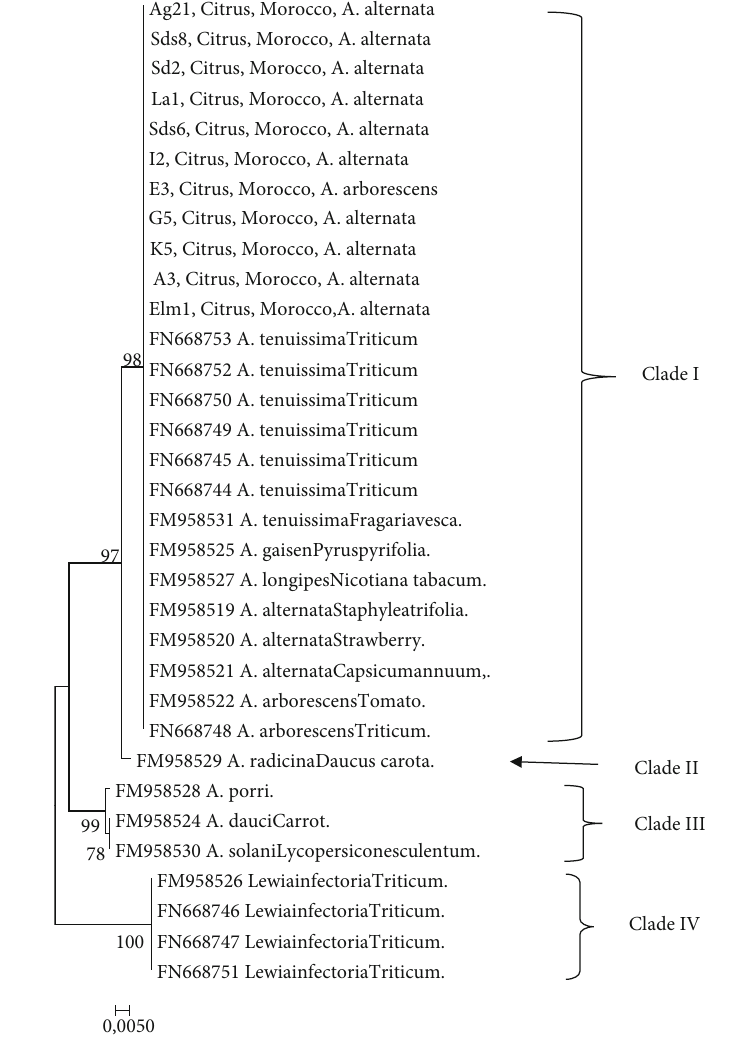
Figure 4: Phylogenetic tree based on the internal transcribed spacer (ITS) sequences of 11 isolates of Alternaria spp. obtained from citrus fruit. The bootstrap value support is indicated in the